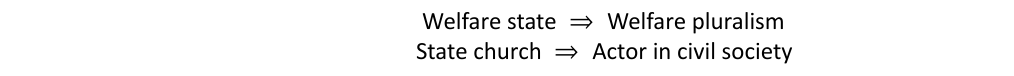
Figure 1. Trajectory over the last five decades de-regulation of welfare state and state church. Social Inclusion, 2019, Volume 7, Issue 2, Pages